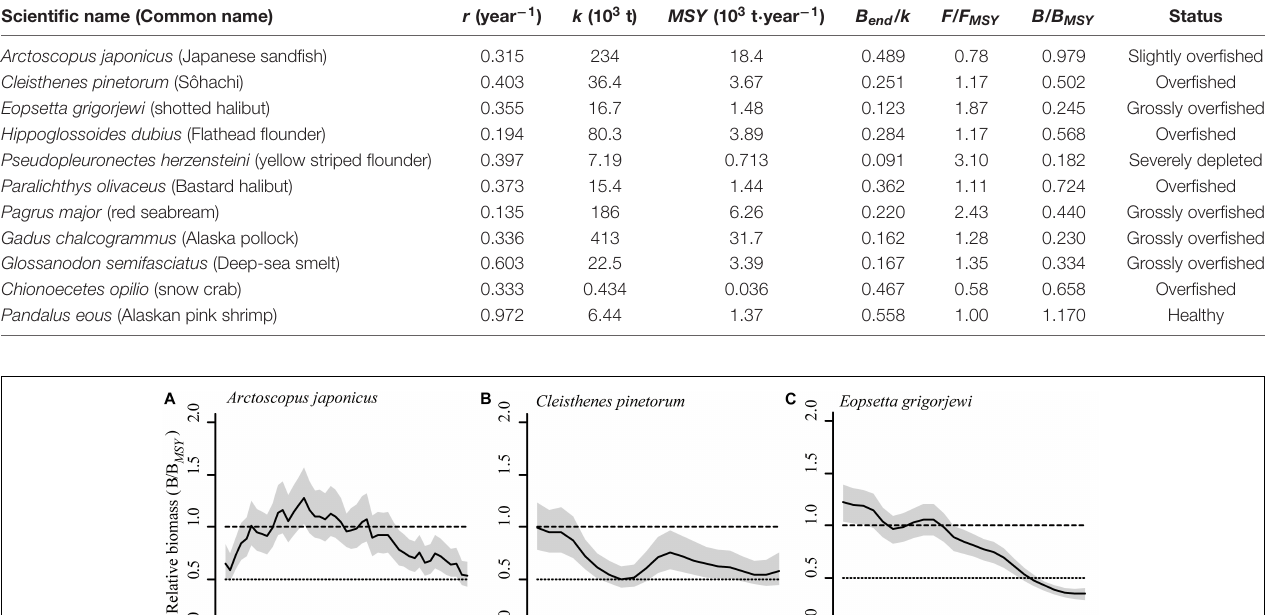
TABLE 5 | Summary of r , k , MSY , relative biomass, and status for 11 populations assessed using the BSM methods.